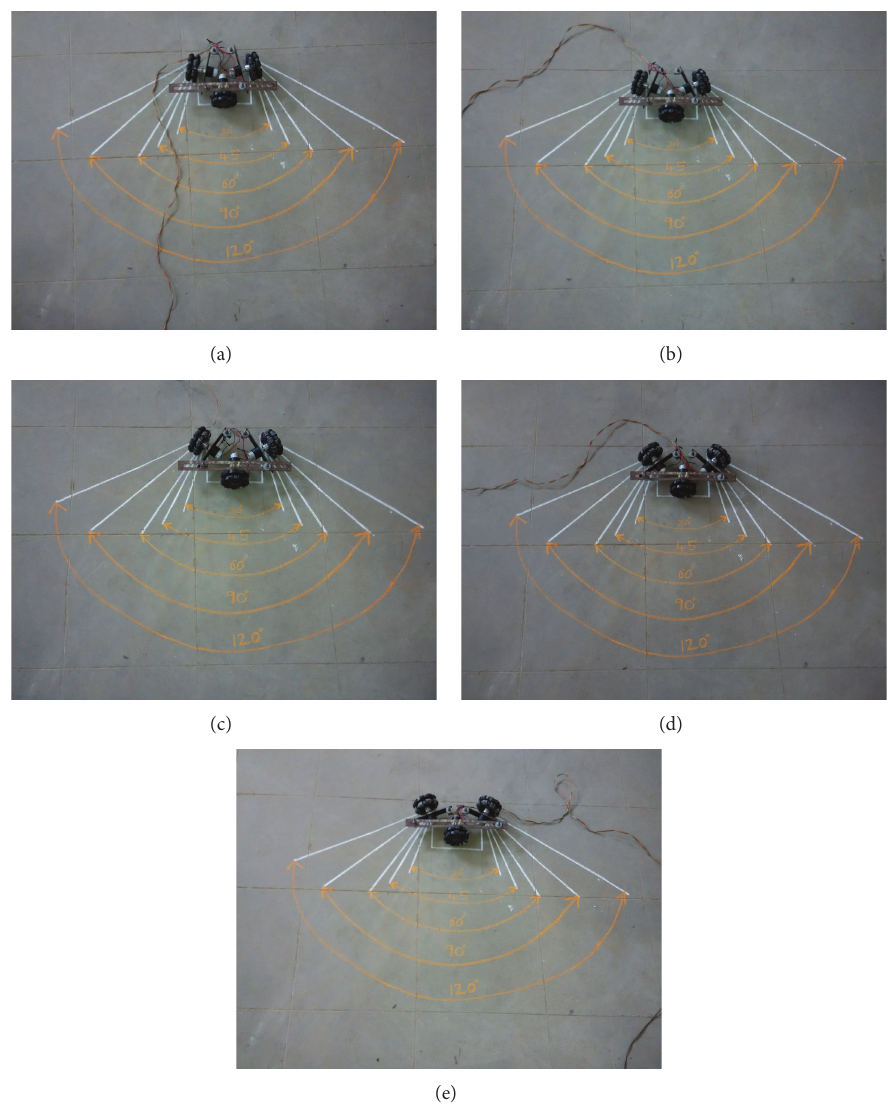
Figure 9: Three-wheeled omnidirectional mobile robot (TWOMR). (a) 𝜃 = 30 ∘ , (b) 𝜃 = 45 ∘ , (c) 𝜃 = 60 ∘ , (d) 𝜃 = 90 ∘ , and (e) 𝜃 = 120 ∘ .